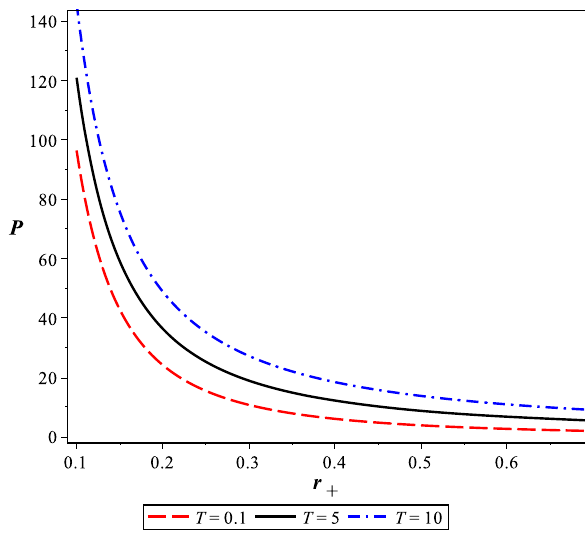
Fig. 1 P − r + diagram in the four-dimensional case, for σ =